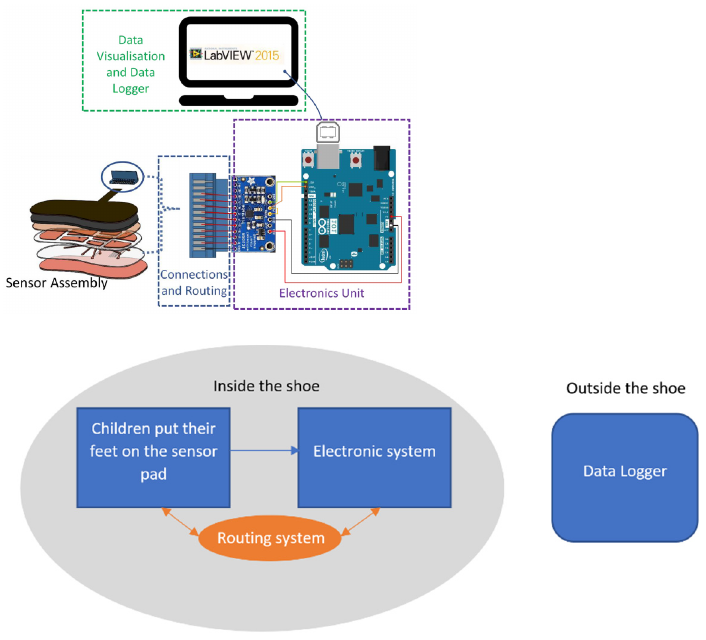
Figure 1. System layout of foot pressure measurement system.